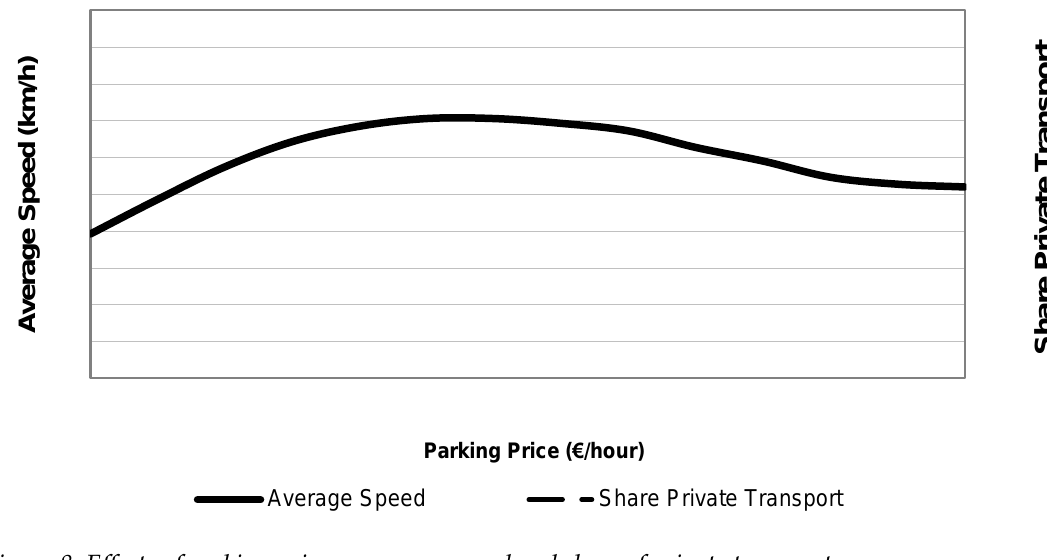
Figure 8. Effects of parking price on average speed and share of private transport The optimization of price under different public parking supply levels reveals that, after a certain amount of supply, the optimal price and speed are approximately constant. Up to that supply level it is beneficial to increase supply. The theoretical logic of this result is that after there is enough parking supply as to eliminate scarcity of parking space conducting to search and access time losses, no further effect on the system is obtained from additional parking supply. On the other side, under increased scarcity of supply higher prices are necessary to avoid inefficiently high search and access times.